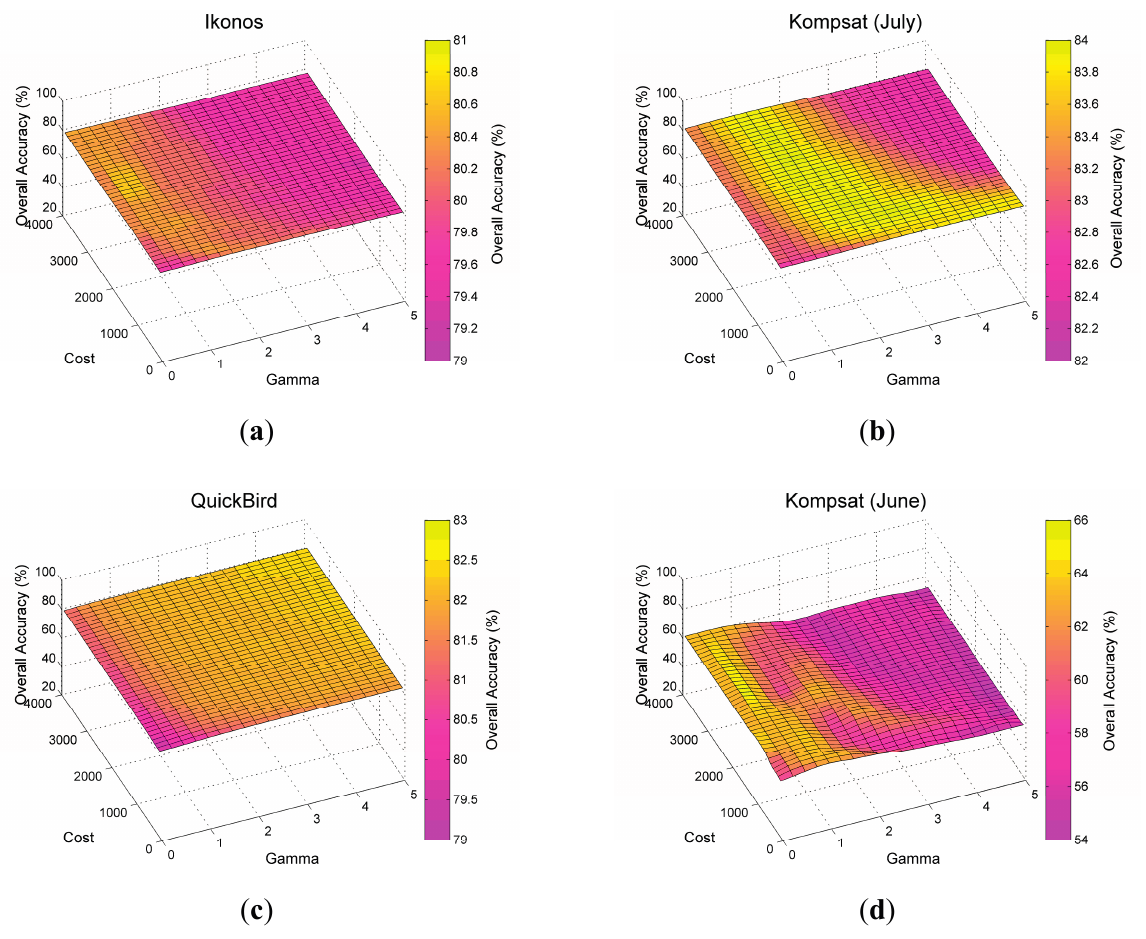
Figure 13. Sensitivity of SVM parameters with respect to overall accuracy. Please note the different scales of the color